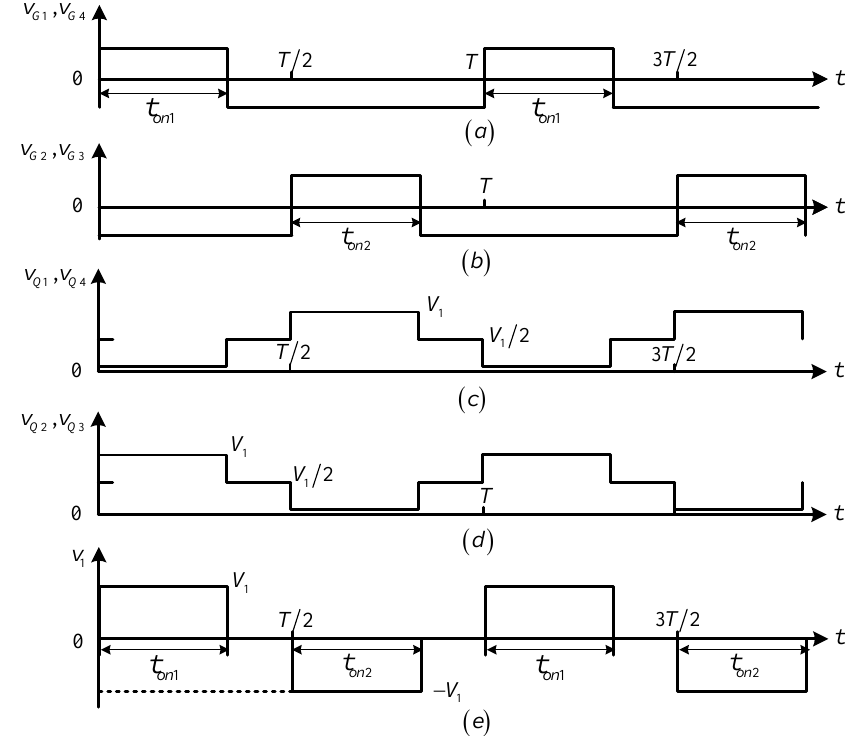
Figure 2. The key waveforms in the single-phase full-bridge DC-DC converter: ( a , b ) represent the gating signals for Q 1 and Q 4, Q 2, and Q 3, respectively. ( c , d ) represent the across voltages of Q 1 and Q 4, Q 2, and Q 3, respectively. ( e ) The voltage across the primary winding v 1